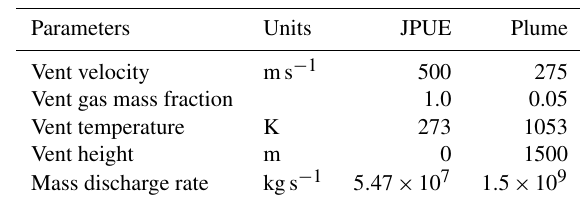
Table 2. List of eruption condition for the test